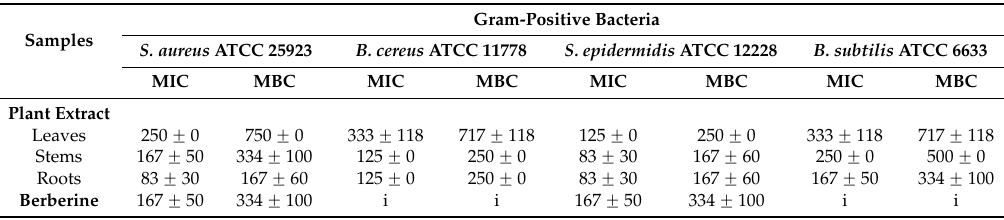
Table 2. Minimum inhibitory concentrations (MICs) a and minimum bactericidal concentrations (MBCs) a of alkaloid extract of Berberis microphylla and berberine against Gram-positive bacteria.